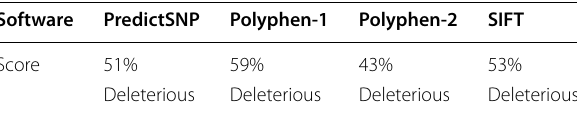
Table 2 Interpretation scores for the pathogenicity of